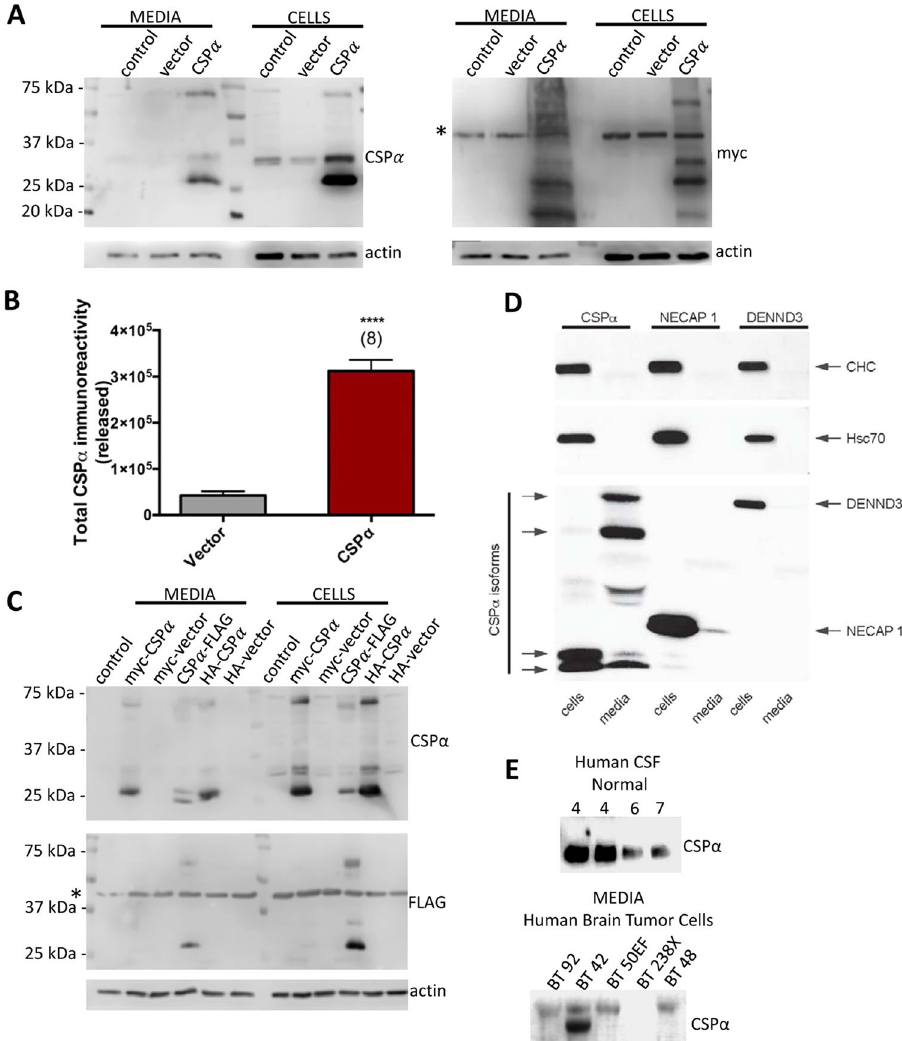
Figure 1. Extracellular release of CSP α . ( A ) Representative immunoblot of media and cell lysates from untransfected, vector and CSP α transfected cells. CAD cells transfected with 3.75 μ g of cDNA encoding myc- tagged WT CSP α or vector control were lysed 48 hrs post-transfection and corresponding cell lysates (15 µ g) and 10X concentrated media (40 µ l) were evaluated by immunoblot with the indicated antibodies. * Indicates a non-specific band. ( B ) Quantification of immunoreative CSP α from vector and CSP α transfected cells ( **** P < 0.0001) as determined by anti-myc monoclonal. These results are representative of 8 independent